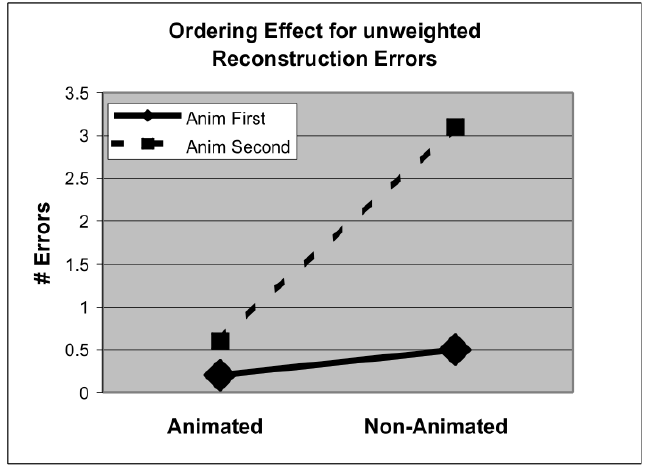
Figure 28. Bederson and Boltman show the ordering effects when presenting an animated and non-animated graphic. If the animated graphic is shown first then there is little difference in recall error, however, if the animation graphic is shown second then the recall error is significantly higher for the non-animated graphic [52]. Image courtesy of Bederson and Boltman